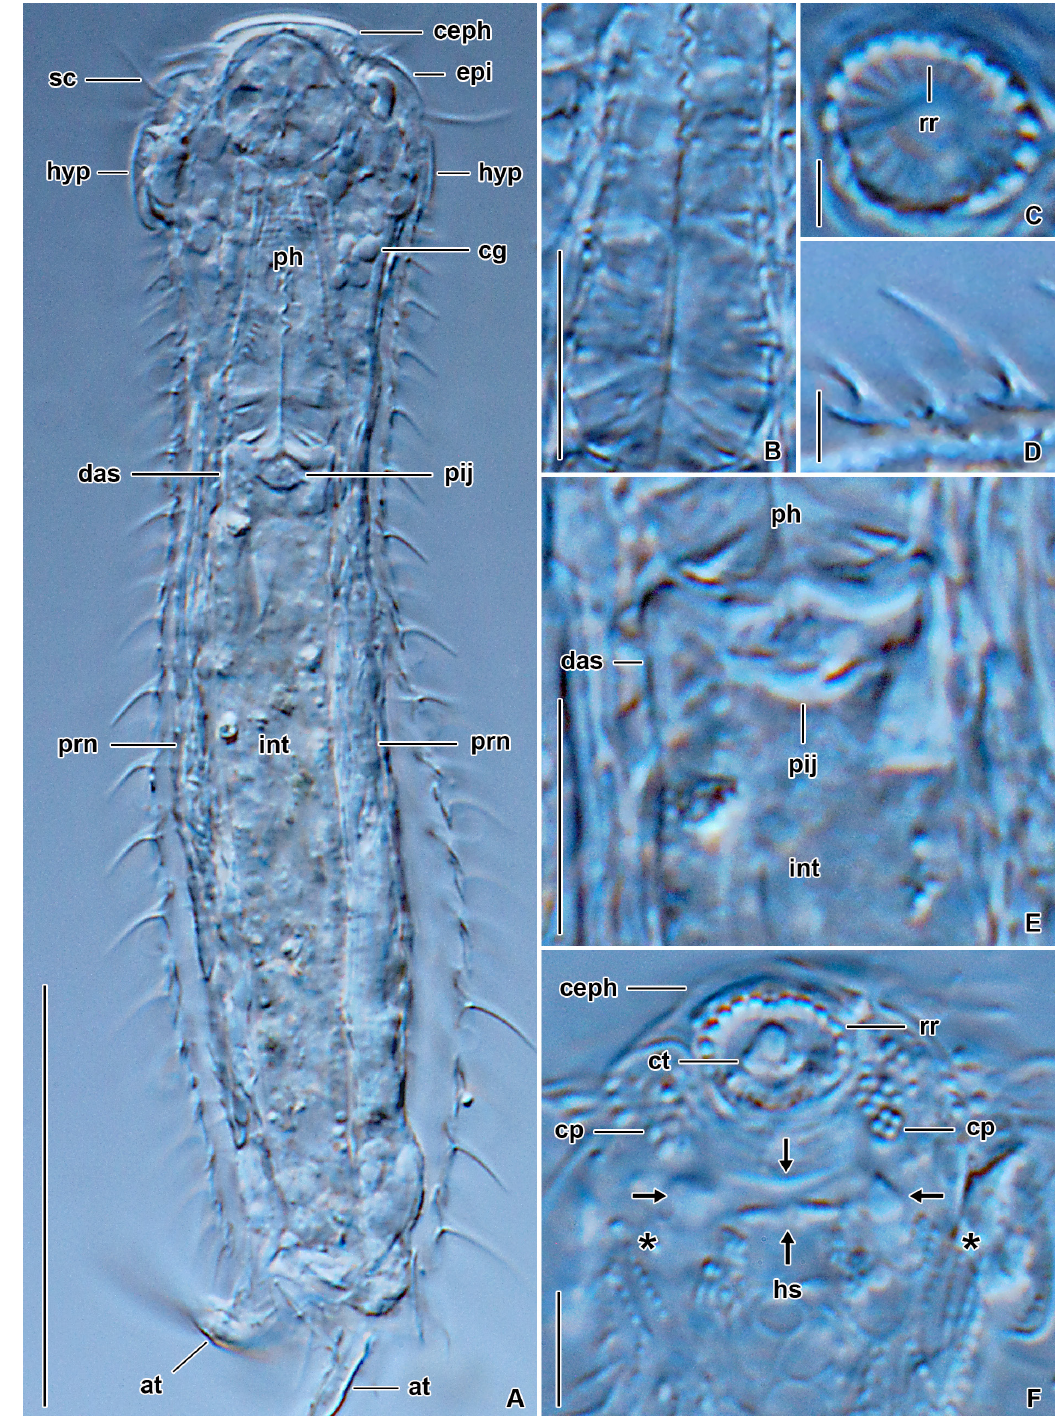
Fig. 32. Chaetonotus ( Hystricochaetonotus ) iratus sp. nov., holotype (CU-FNS-21-09-20/HO), differential interference contrast. A . Overview showing the internal morphology. B . Pharynx. C . Mouth. D . Head scales. E . Detail showing the posterior section of the pharynx, the pharyngeal-intestinal junction, and the differentiated anterior section of the intestine. F . Detail of the mouth region. Arrows mark the hypostomial structures, asterisks mark the beginning of ciliary bands. Scale bars: A = 30 µm; B = 10 µm; C–D = 2 µm; E–F = 5